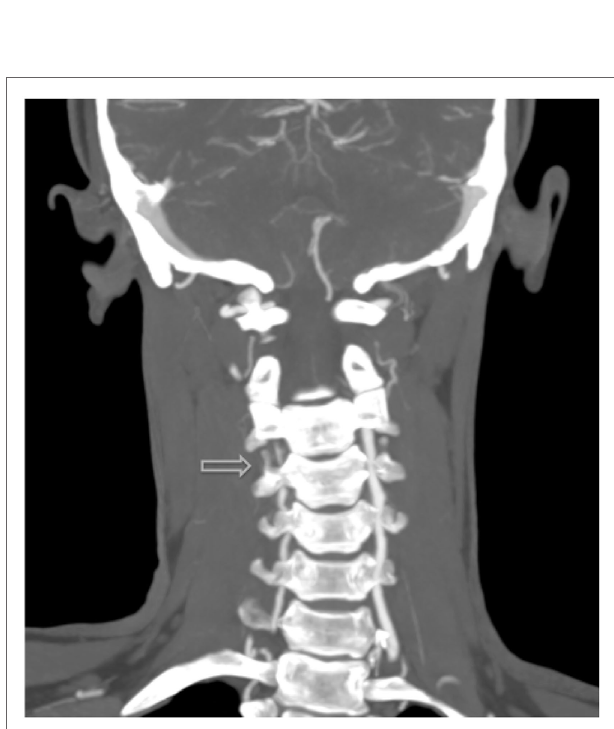
FIgURe 1 | Arterial dissections noted in both vertebral arteries on MRI angiography following the patient’s second week on lenvatinib (14 mg)